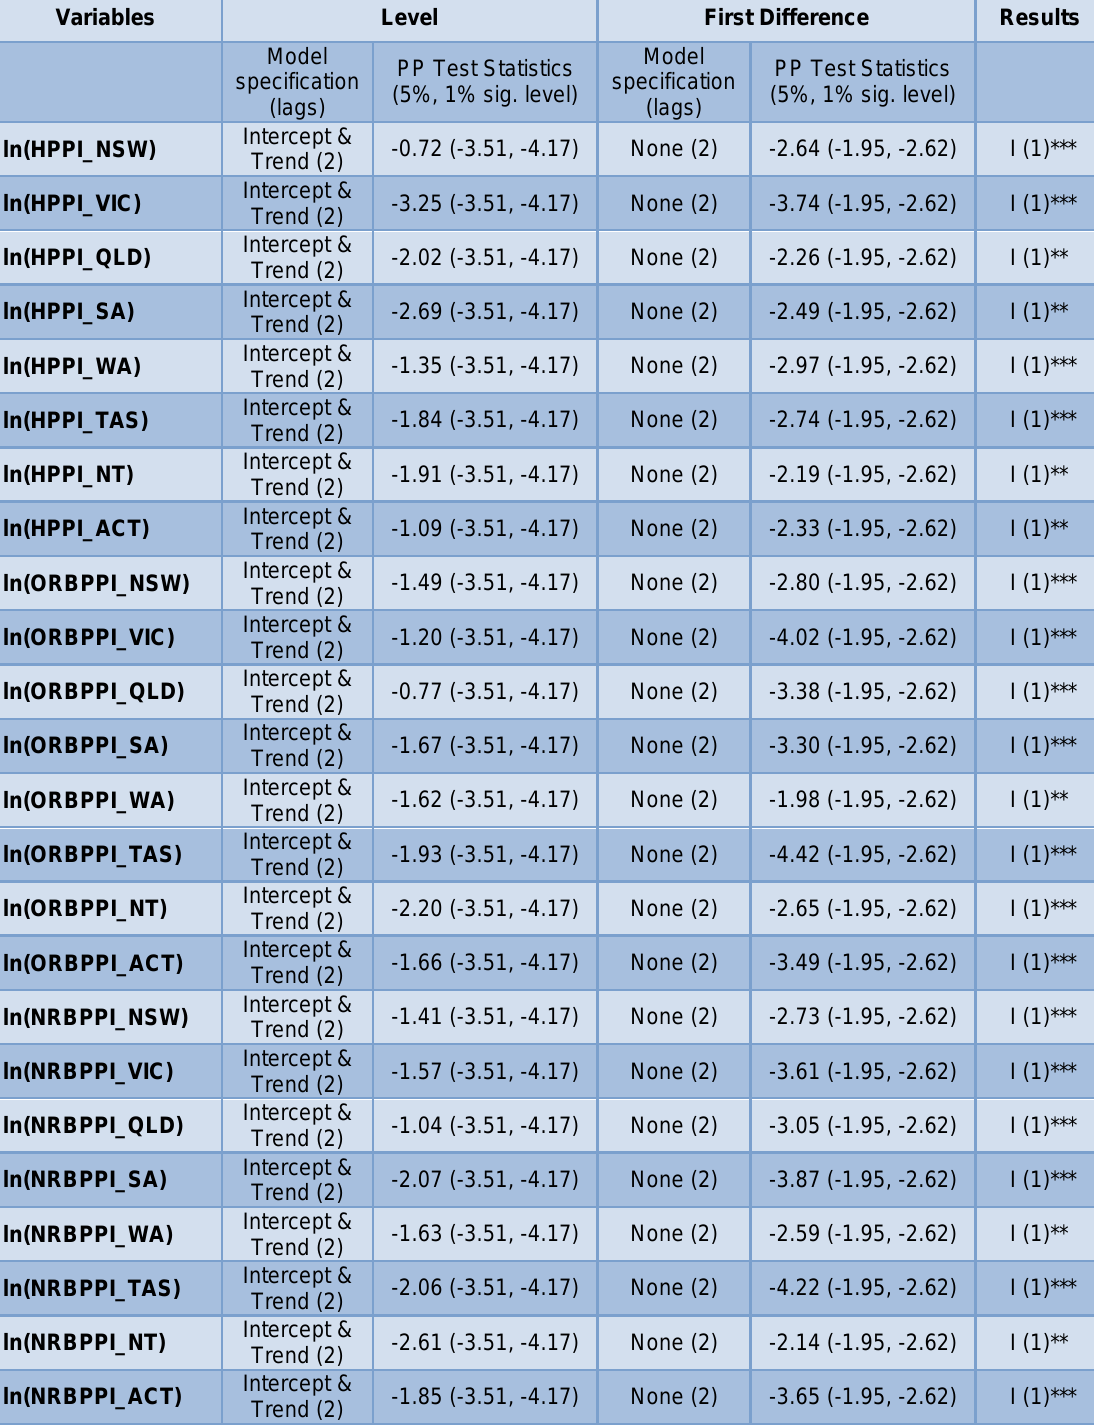
Table 2: PP tests of the variables for 1998Q3 – 2010Q1 Notes: The PP Tests, which are the unit root test similar to the ADF Tests, contain three kinds of model specification: only intercept, trend and intercept, and no trend and no intercept. ** and *** denote the 95% and 99% significance